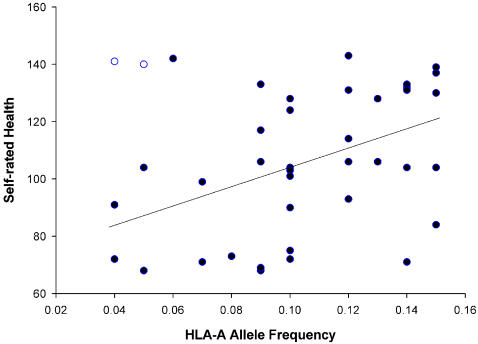
The relationship between HLA-A allele frequency and self–rated health.Outliers are indicated as open circles.